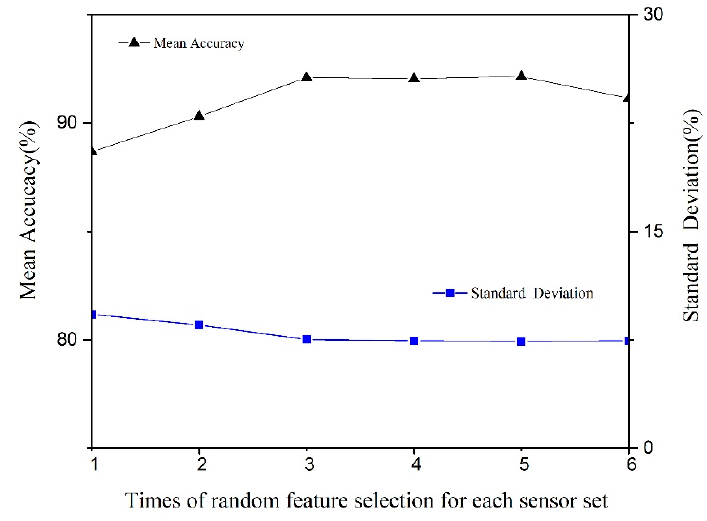
Figure 6. Classification results with respect to different feature selection times.